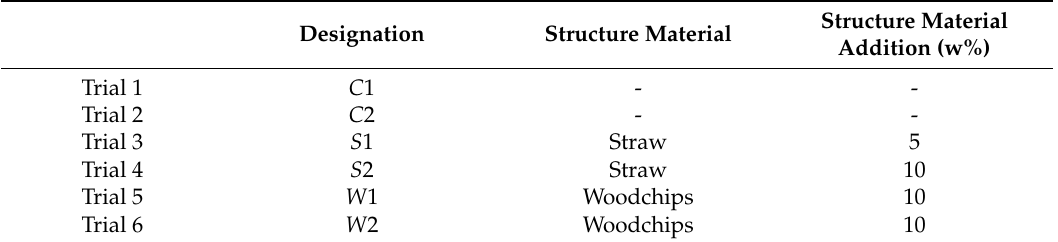
Table 1. Dry batch anaerobic digestion trials and structure material